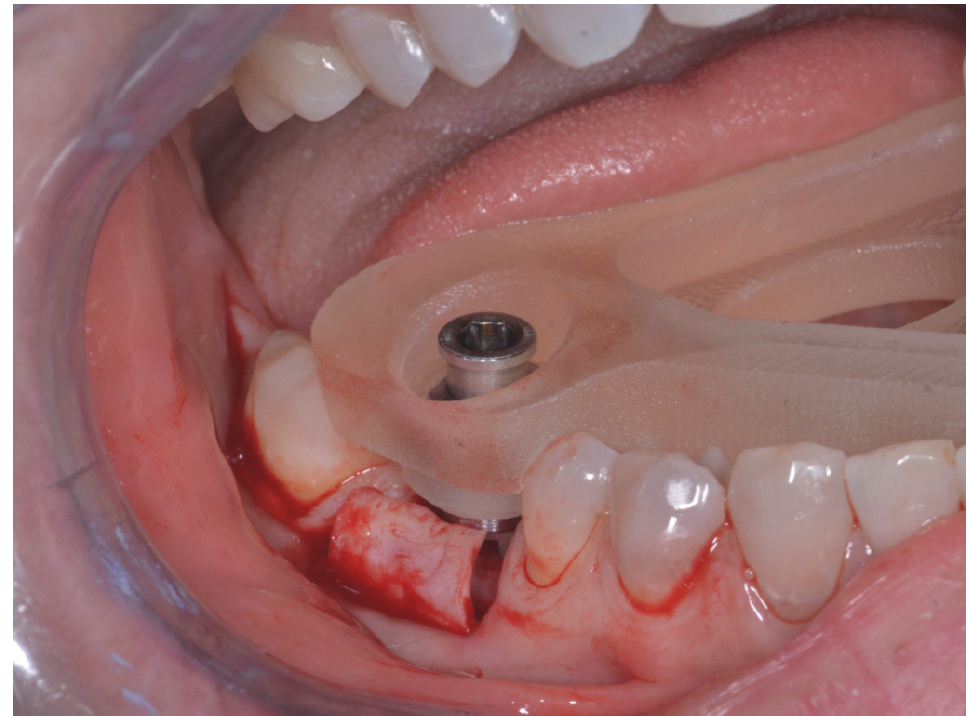
Figure 7. Intraoperative view of the guided cortical drill after insertion into the sleeve.